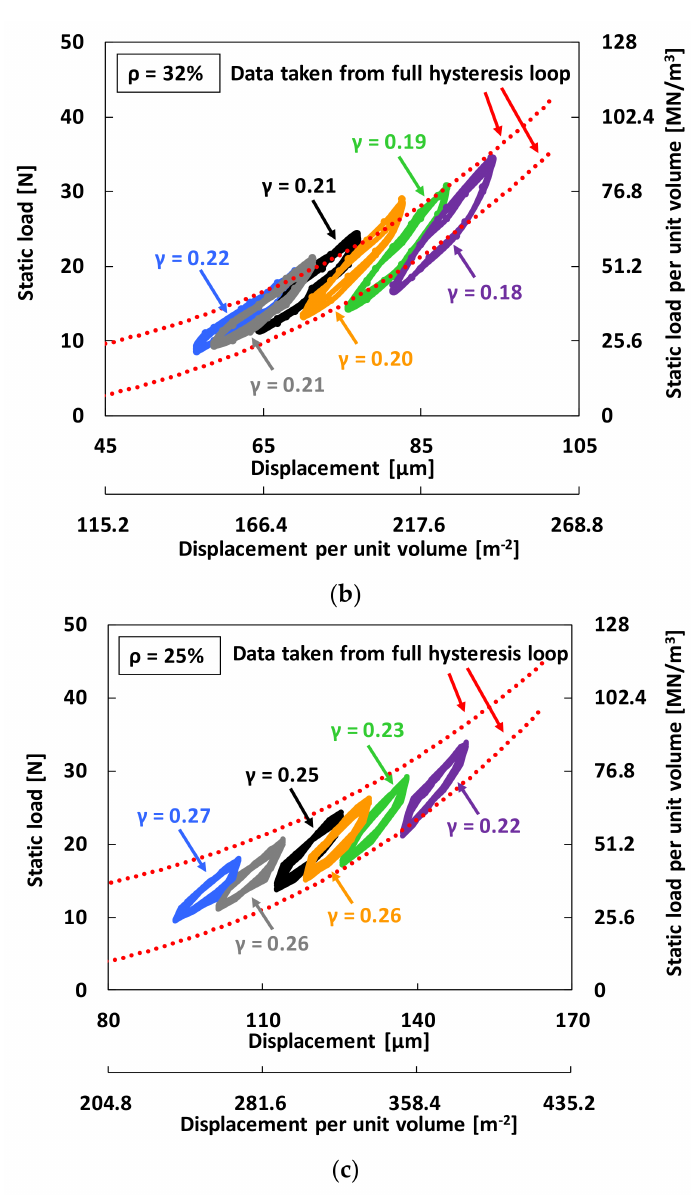
Figure 8. Local hysteresis loop measurements: Static load F S (left vertical axis) and static load F S per unit volume (right vertical axis) versus displacement (upper horizontal axis) and versus displacement per unit volume of WMD (lower horizontal axis). ( a ) WMD of 42% density; ( b ) WMD of 32% density; ( c ) WMD of 25%